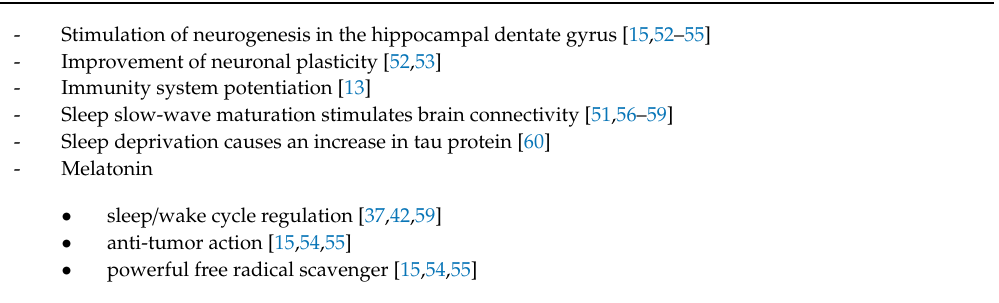
Table 2. The identified roles of sleep in the development of the central nervous system and